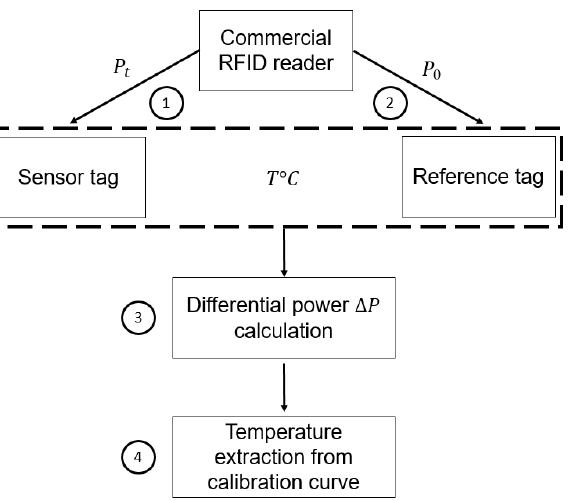
Figure 5. The proposed methodology of temperature extraction with a differential approach using a commercial RFID reader.